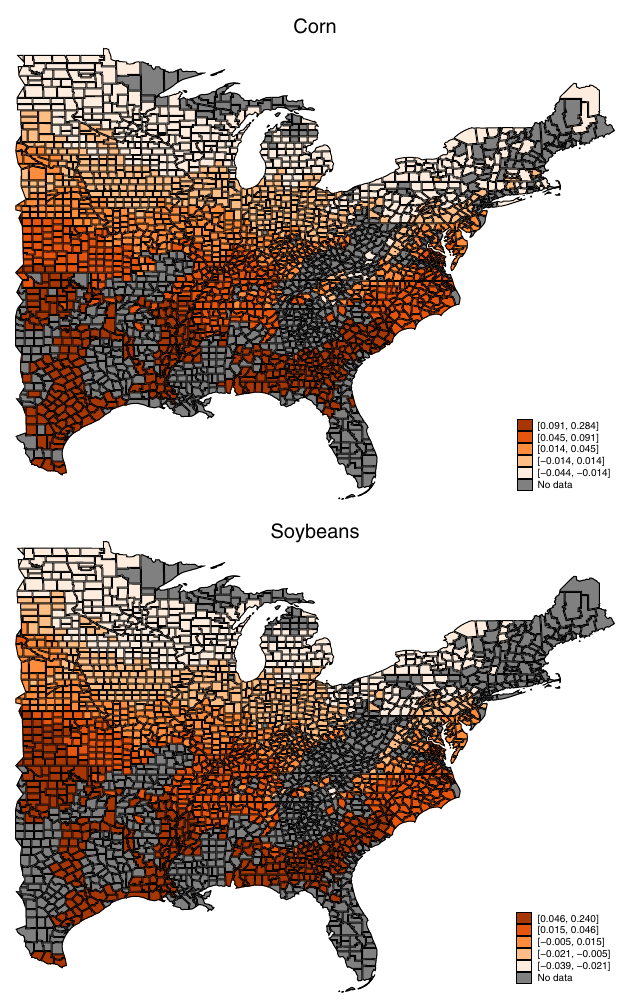
Fig. 4 Spatial distribution of a 1 °C warming impact on the county-level average aggregate loss – cost ratio (LCR), 1989 – 2014 ( N = 30,261 for corn and N = 29,014 for soybeans). For the uniform 1 °C warming scenario, the predictions are based on the estimated coef fi cients of the total LCR model (assuming no precipitation changes). The darker colors represent greater impacts on the average